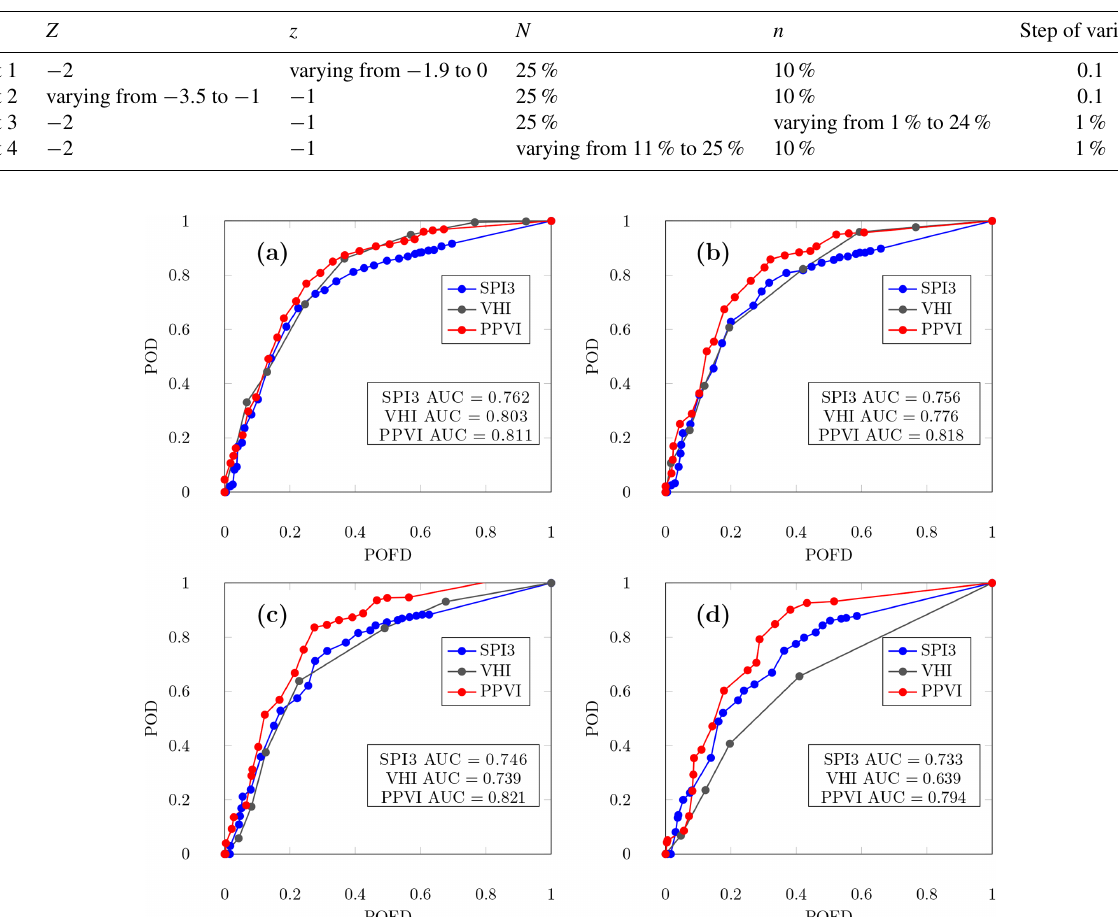
Table 9. Example of set of thresholds used to draw ROC curves for model calibration. Thresholds N and n are expressed as the percentage of the country’s area instead of as the number of grid cells.